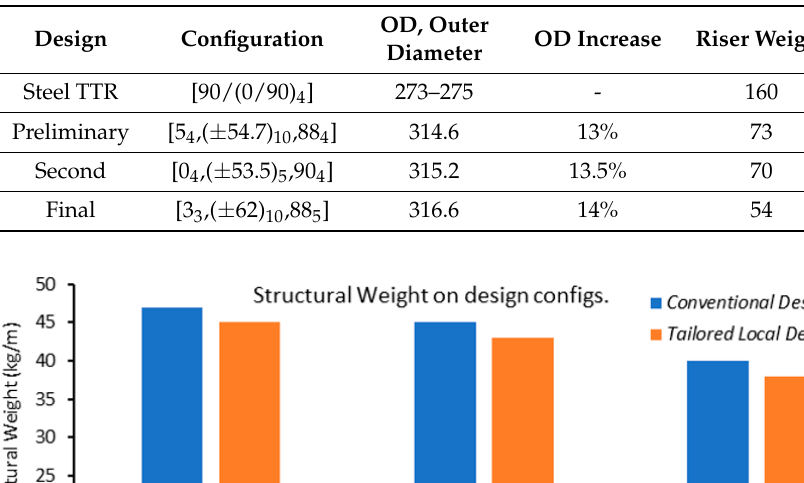
Table 14. Comparison of weights between a typical TTR steel riser and composite riser.